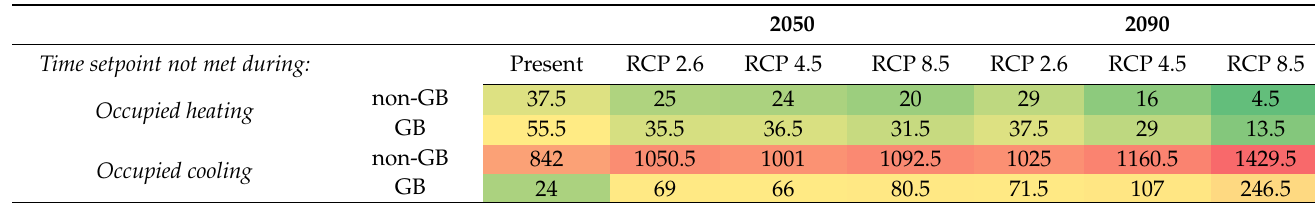
Table 3. Unmet hours for heating and cooling periods for both GB and non-GB.